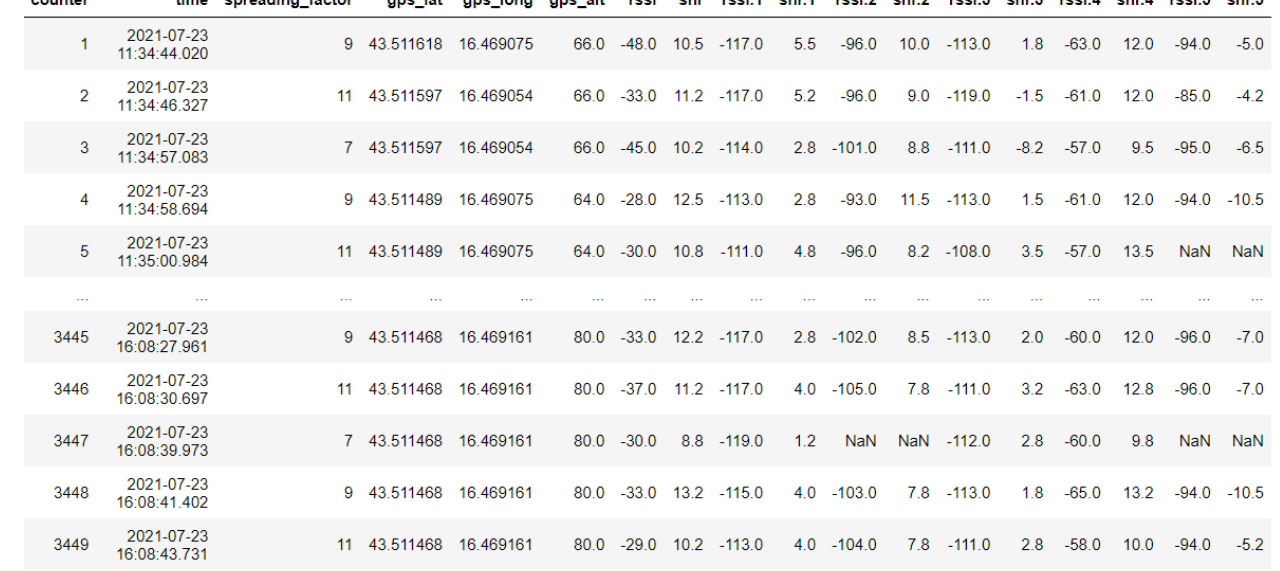
Figure 6. Snapshot of a LoRa Dataframe for location 1, room